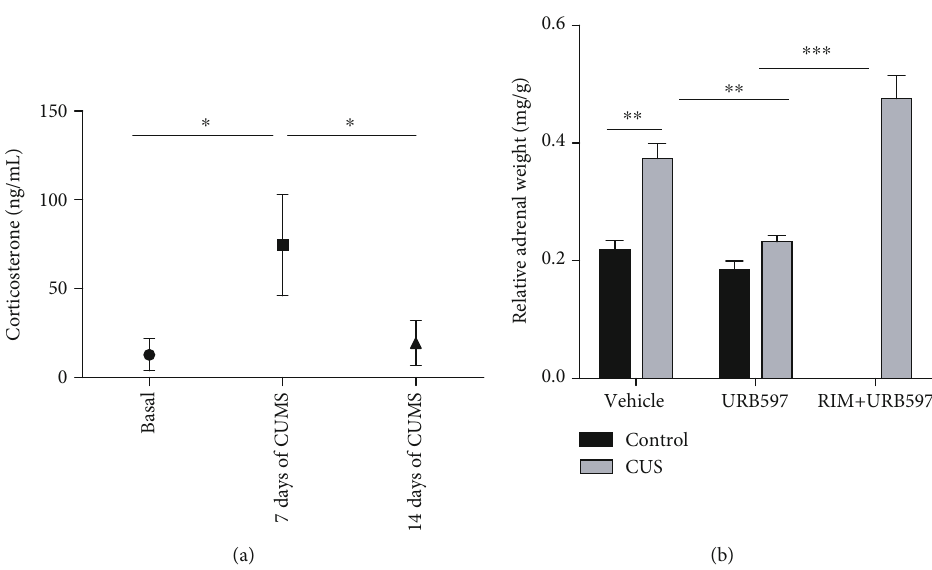
Figure 2: (a) Results of serum corticosterone concentrations at days 0, 7, and 14 of CUS exposure. The columns represent the mean ± SEM , n = 5 /group. ∗ Statistically signi fi cant di ff erences, p ≤ 0 : 05 ; Kruskal-Wallis. (b) The right graph shows the relative weights of the adrenal glands at the end of the experiment. The columns represent the mean ± SEM , n = 6 /group; ∗∗ p ≤ 0 : 01 ; ∗∗∗ p ≤ 0 : 001 . Two-way ANOVA post hoc Holm-Sidak ’ s.